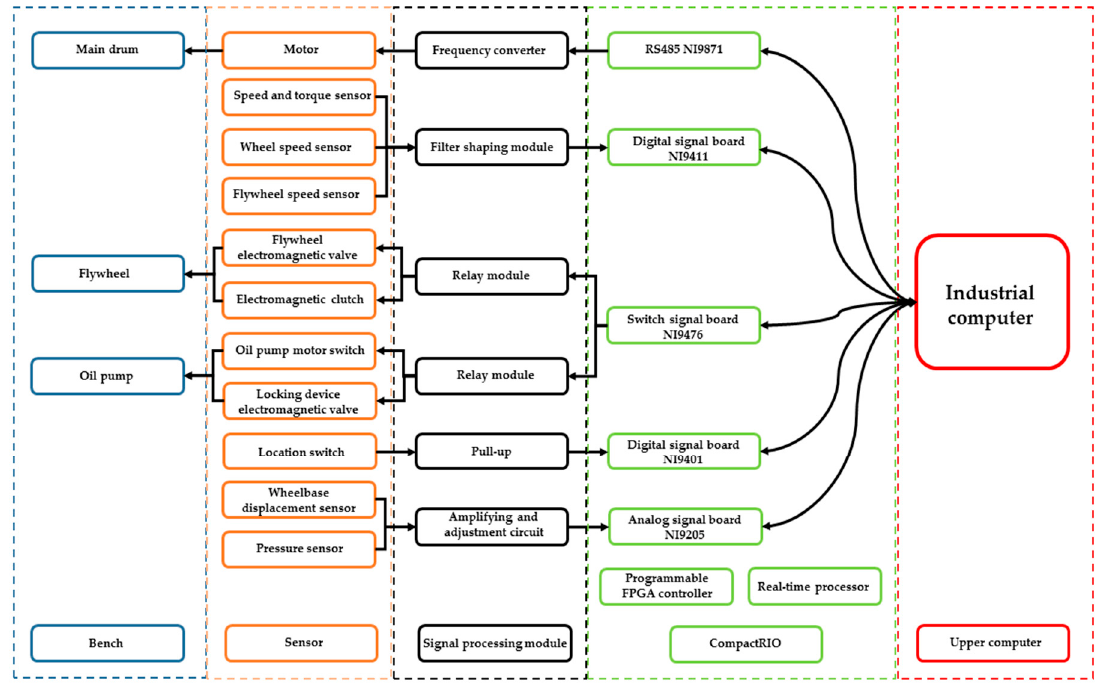
Figure 2. Framework structure of measurement and control system.